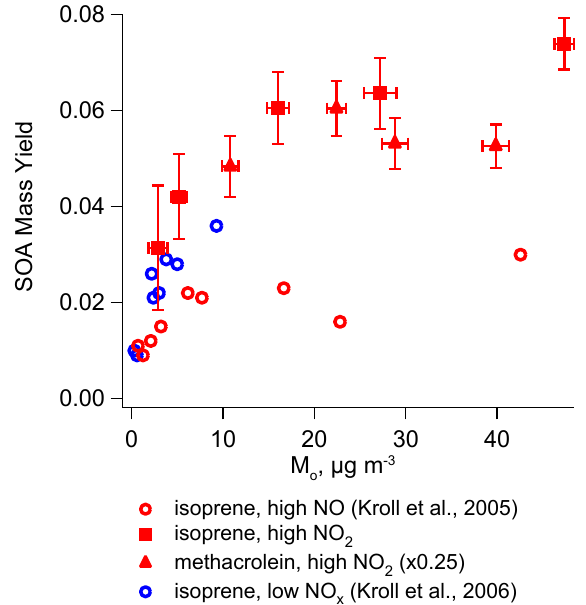
Fig. 11. SOA mass yields from isoprene photooxidation under neutral seed conditions as a function of organic loading. The solid markers indicate SOA yields measured in this study, using CH 3 ONO as the OH precursor under high NO 2 /NO ratios (between 3 and 8). The SOA yields for methacrolein (solid red triangles) have been multiplied by 0.25 to account for the gas-phase product yield of methacrolein from isoprene high-NO x oxidation. The SOA yields measured under high-NO 2 /NO conditions are higher than both high-NO (open red circles) and low-NO x conditions (open blue circles) under neutral seed conditions. With an acidified seed, SOA yields can be as high as 0.29 (Surratt et al., 2010).